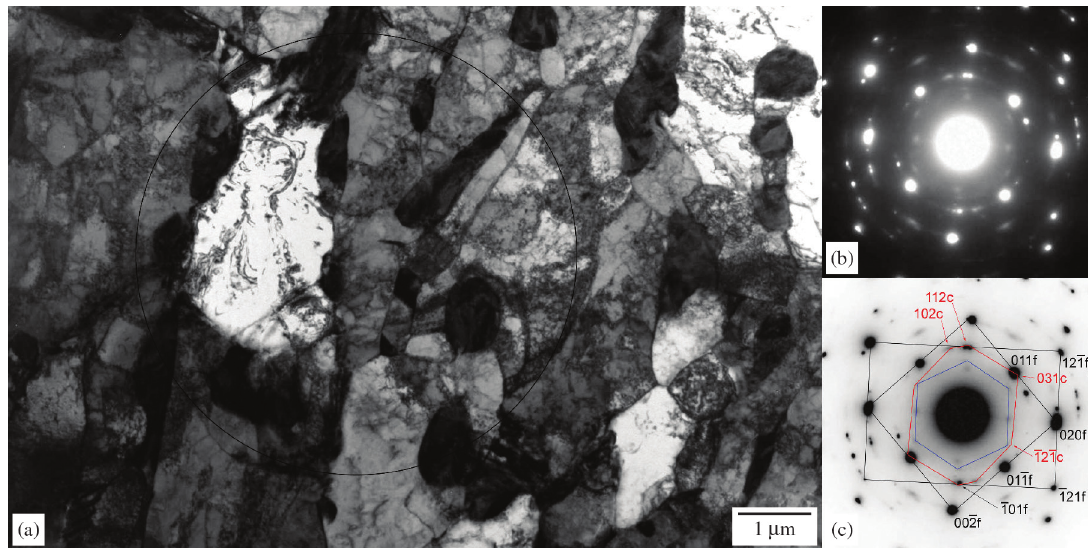
Figure 6. TEM BF micrograph showing in (a) evidences of partial recrystallization in deformed bainite/martensite laths. Electron diffraction pattern of the encircled area presenting complex ferrite orientation in (b) and its key diagram in (c) shows a cementite orientation close – to [201 ]c in a region with ferrite zone axis between [100]f and [101]f.